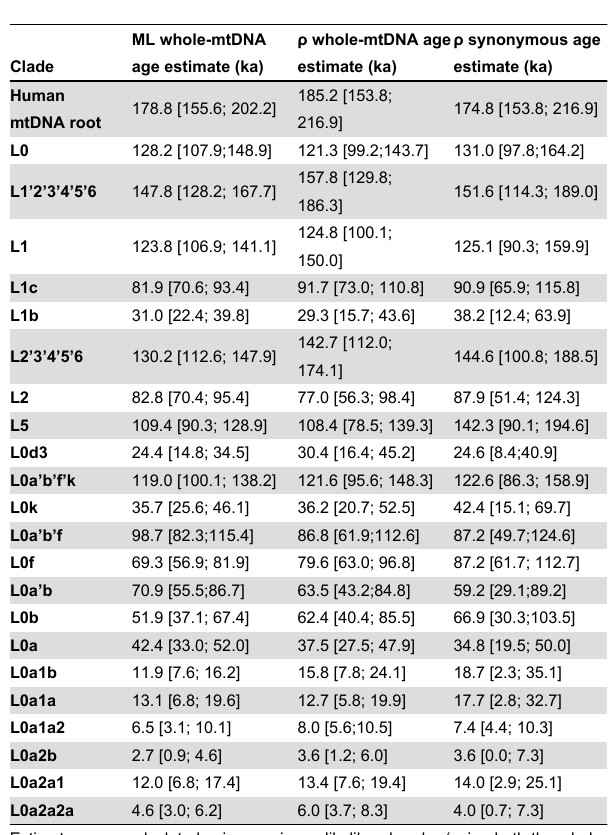
Table 1. Age estimates referred to in this